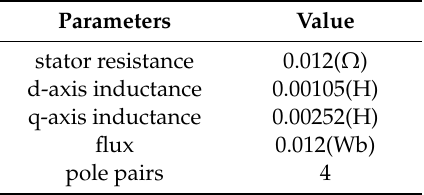
Figure 9. The experiment equipment. ( a ) The double ‐ pulse test equipment. ( b ) The permanent magnet synchronous motor (PMSM) test bench. Table 3. Parameters of the tested motor . Table 3. Parameters of the tested motor.